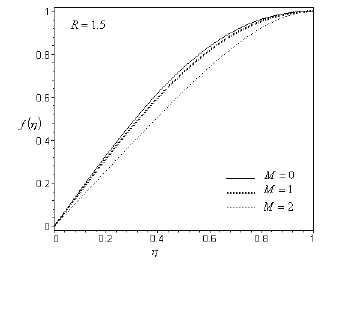
Figure 3. The longitudinal velocity pro- files for different values of magnetic param- eter M, when R = 1 . 5 is fixed.